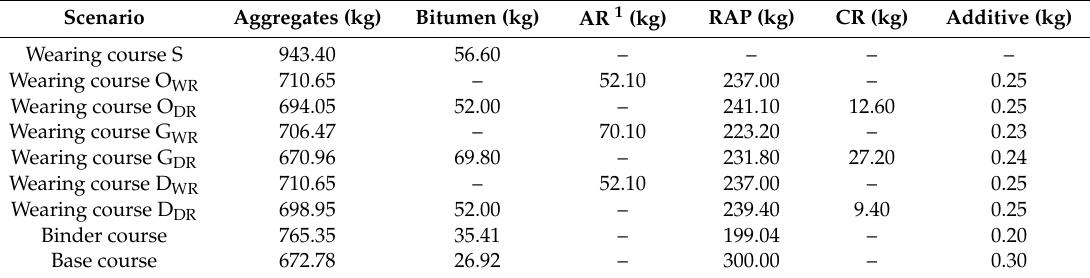
Table 3. Composition of 1 ton of bituminous mixtures.